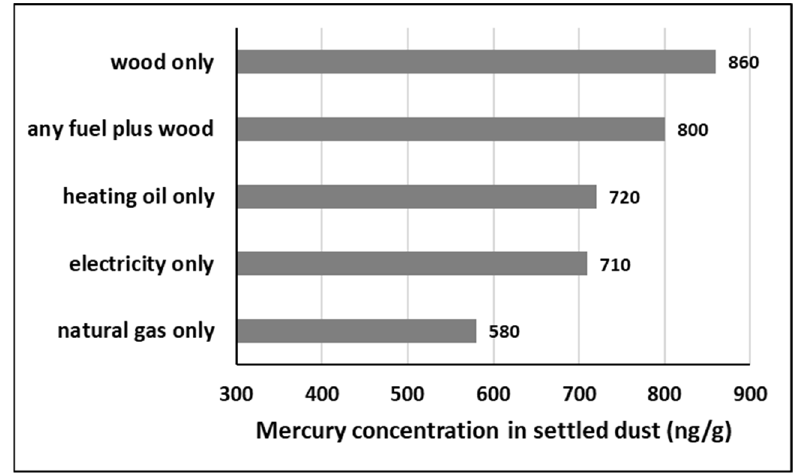
Figure 1. Influence of home heating fuel on mercury concentration in settled house dust (median values; ng/g). See SI-4 for summary of heating styles in CHDS homes.